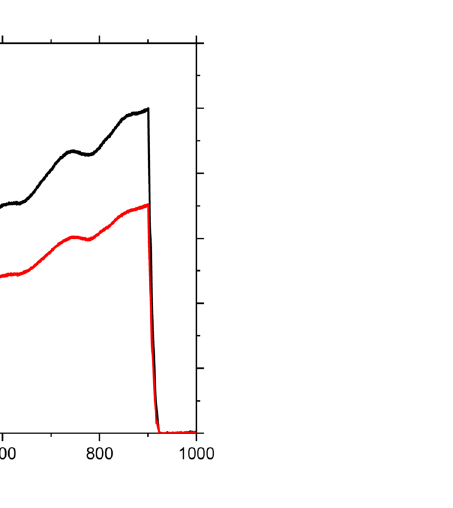
Figure 5. Intensities of the incident and transmitted signals through a mixture of 6200 ppm methane and 8900 ppm benzene in